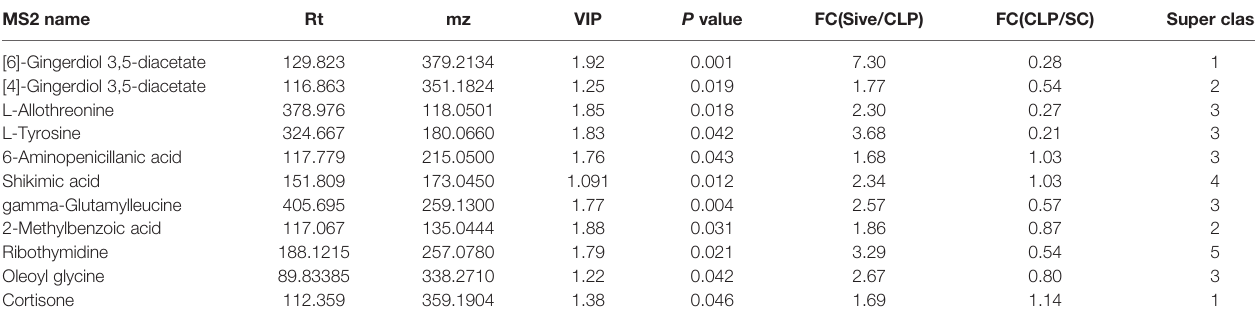
TABLE 2 | Major differential metabolites between Sive and ClP groups.